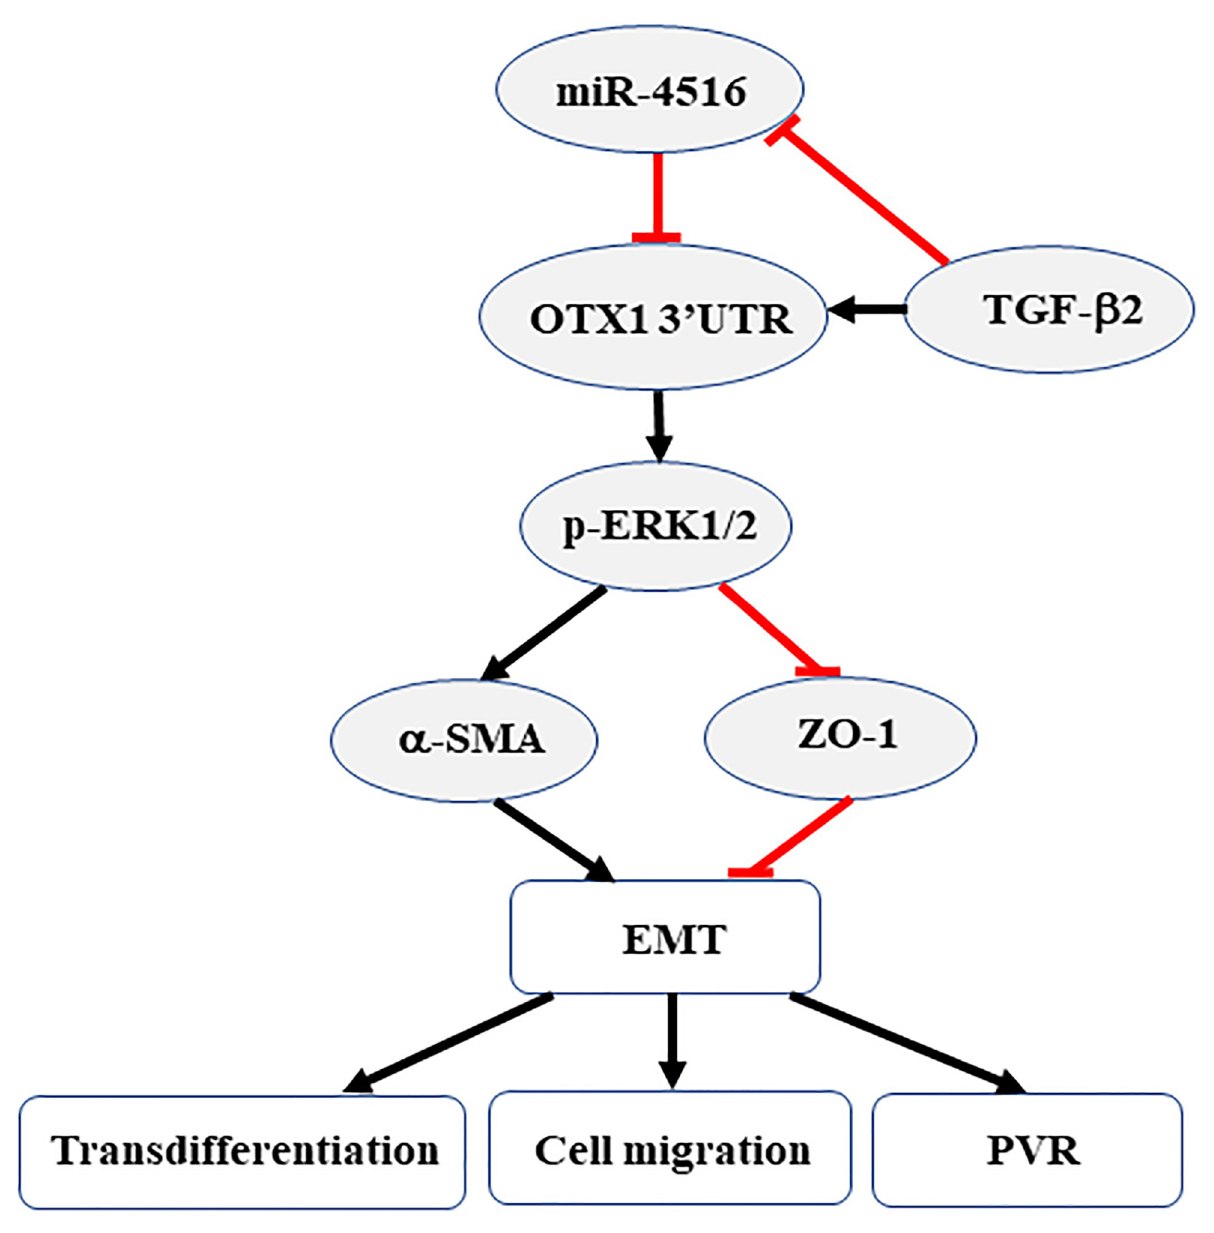
Fig 8. Role of miR-4516 in PVR